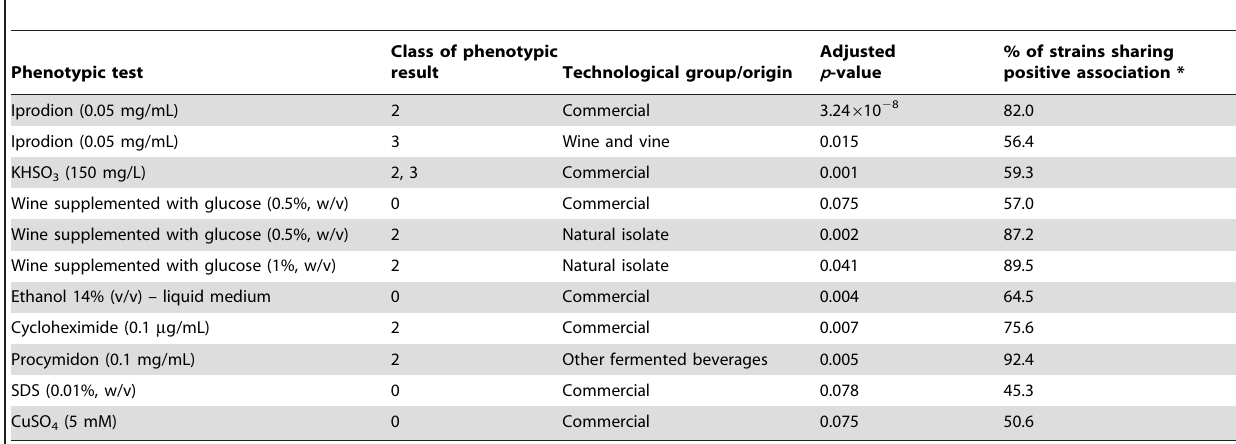
Table 3. Relevant associations (adjusted p , 0.1) between phenotypic results and strain’s technological application or origin, obtained using Mann-Whitney test and after Bonferroni correction.